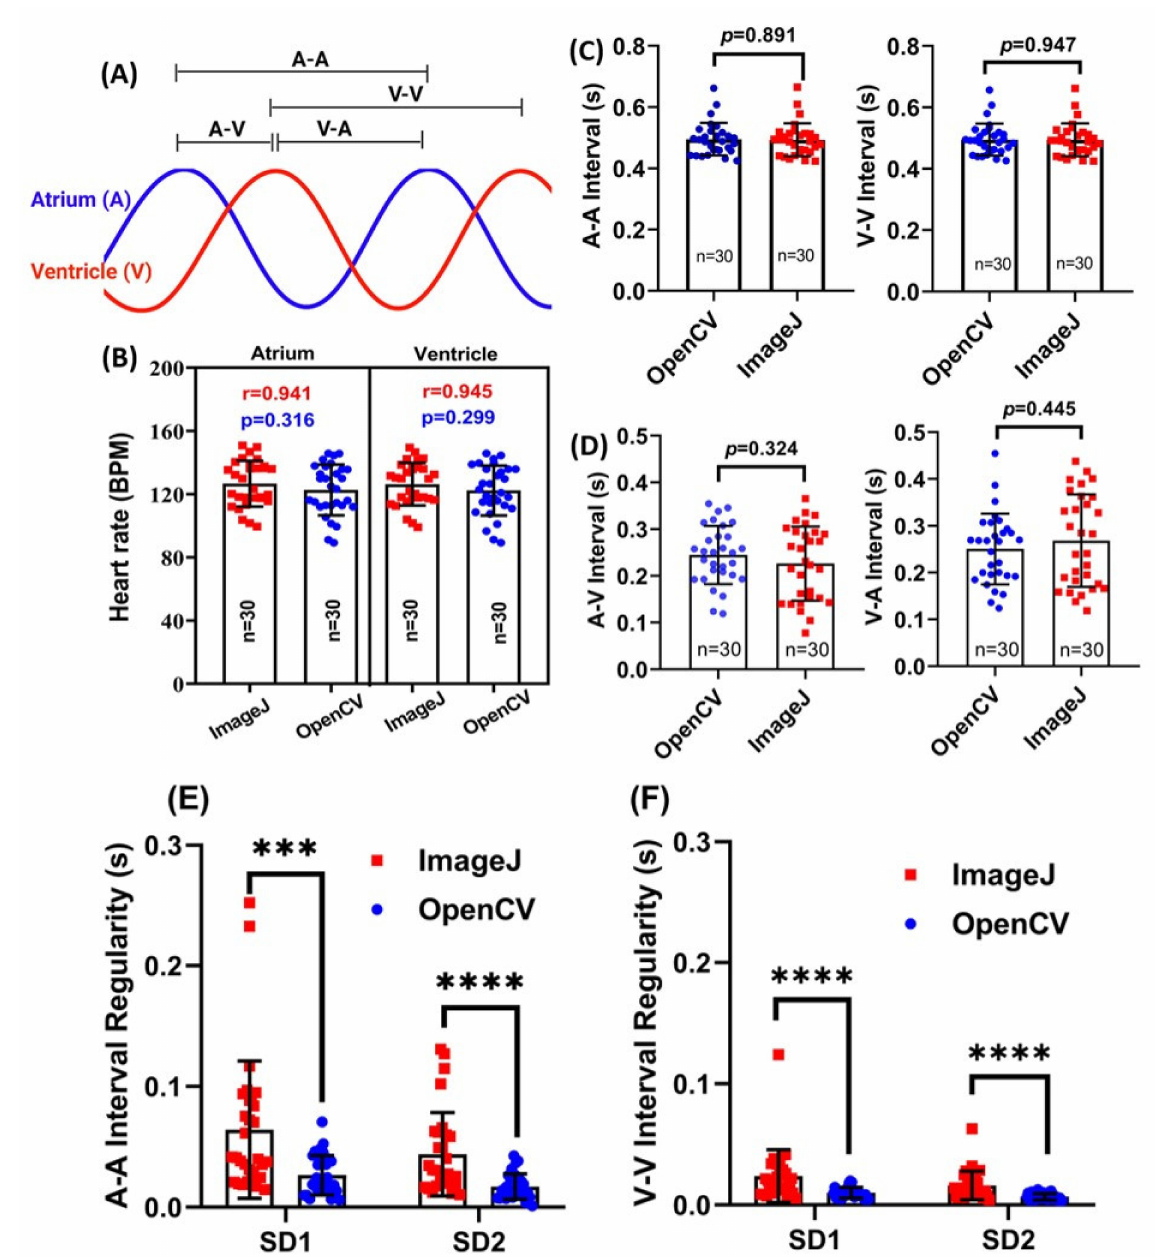
Figure 3. Comparison of heart rate and cardiac rhythm measurement in control zebrafish embryos aged at 72 hpf using either OpenCV or ImageJ methods. ( A ) Schematic diagram showing the basic definition for atrium and ventricle signals. ( B ) Comparison of heart rate obtained from either atrium (left panel) or ventricle (right panel) chambers using either ImageJ or OpenCV methods. ( C ) Comparison of the atrium to atrium (A-A) and ventricle to ventricle (V-V) intervals using either ImageJ or OpenCV methods. ( D ) Comparison of atrium-ventricle (A-V) and ventricle to atrium (V-A) intervals using either ImageJ or OpenCV methods. Comparison of atrium-atrium (A-A) ( E ) and ventricle-ventricle (V-V) ( F ) interval regularity using either ImageJ or OpenCV methods. Data was processed using unpaired t -test ( B – D ) as it follows the normal distribution. Pearson correlation ( B ) and Wilcoxon test ( E , F ) were conducted because the data does not obey normal distribution (*** p < 0.001, **** p <